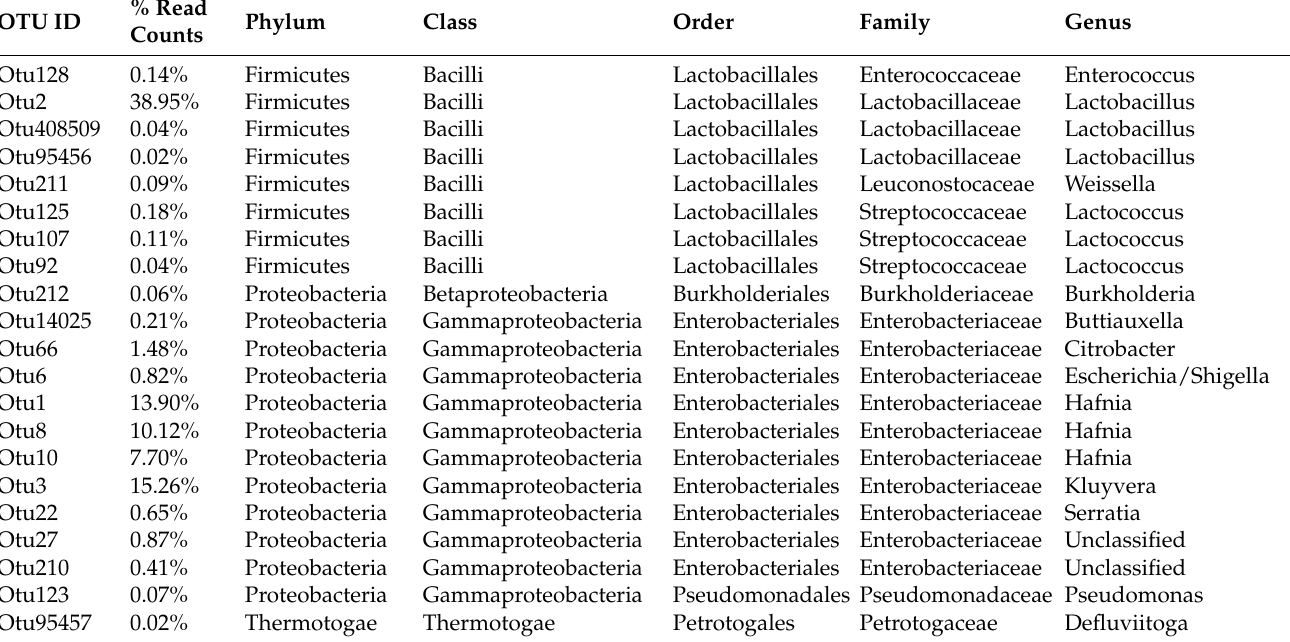
Table 3. Abundance and classification of core